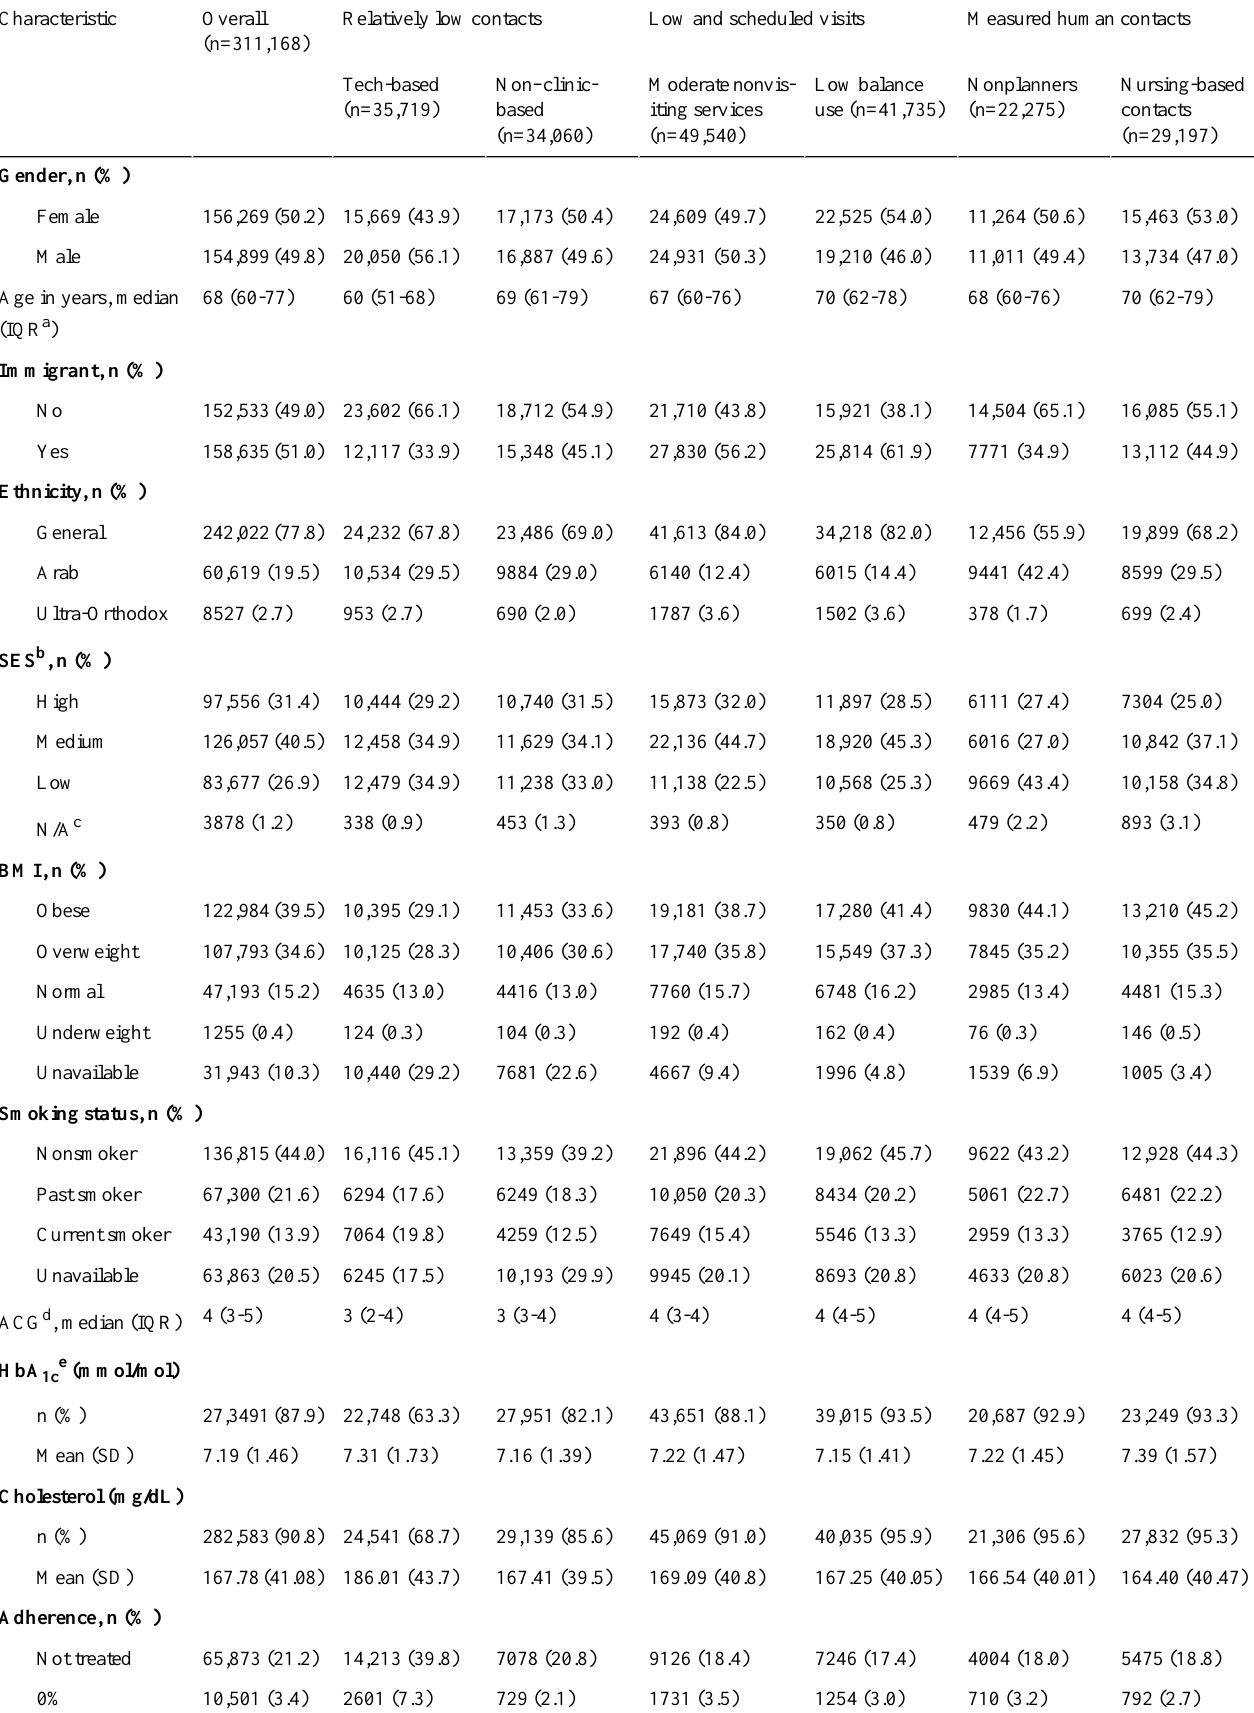
Table 2. Sociodemographic, clinical, and biological measurements data summary for patients with diabetes, in 2016, having a low-to-moderate health care services